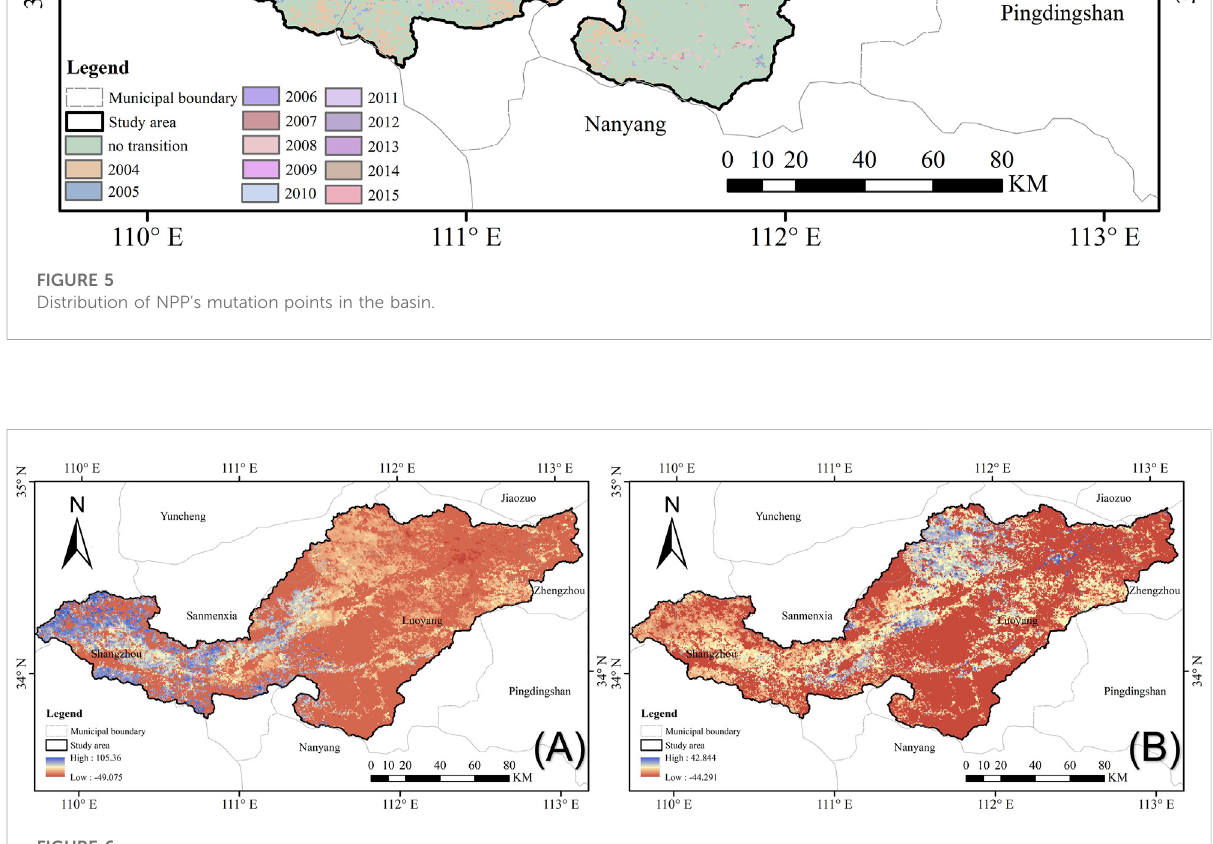
FIGURE 6 NPP ’ s change rate before (A) and after (B) mutation